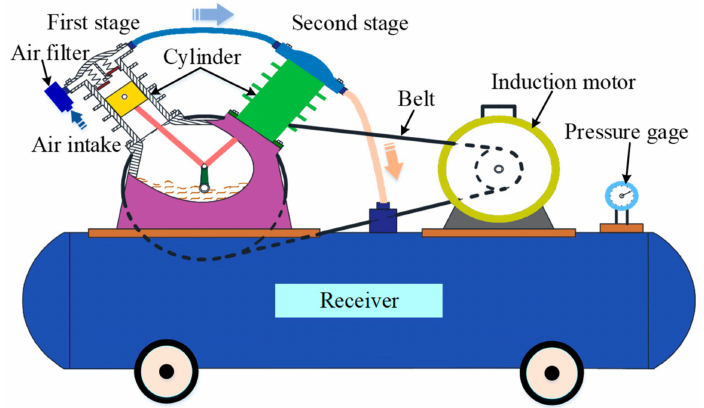
Figure 2. Structure diagram of